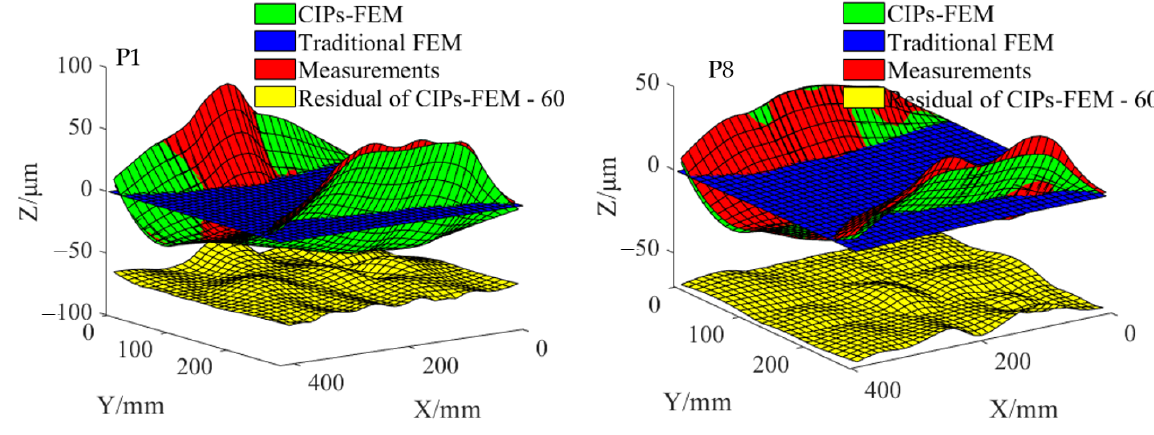
Figure 4. Thermal deformation prediction results.